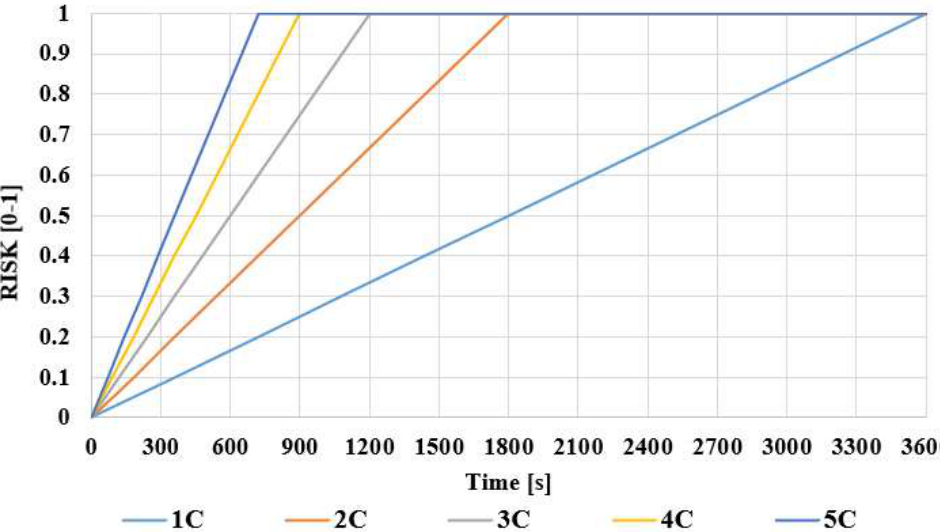
Figure 7. Analysis of the effects of different loads as a function of risk (the 1C…5C values mean the discharging current; thus, if a battery is 3.7 Ah, 1C means 3.7 A discharging current, 2C means 7.4 A discharging current, and so on).